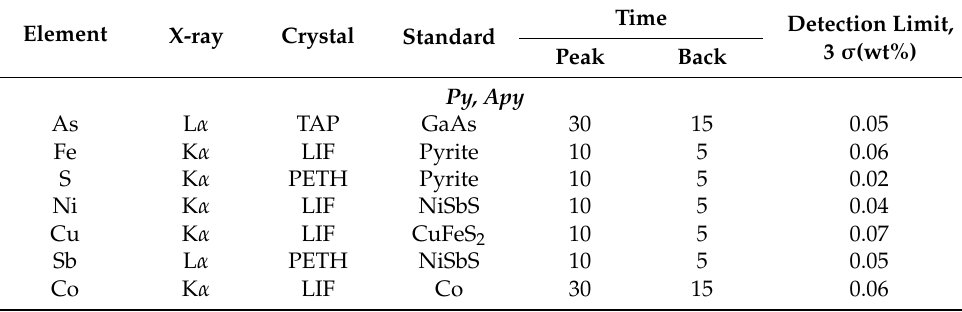
Table A1. Standards used for routine mineral analysis by EPMA (I = 20